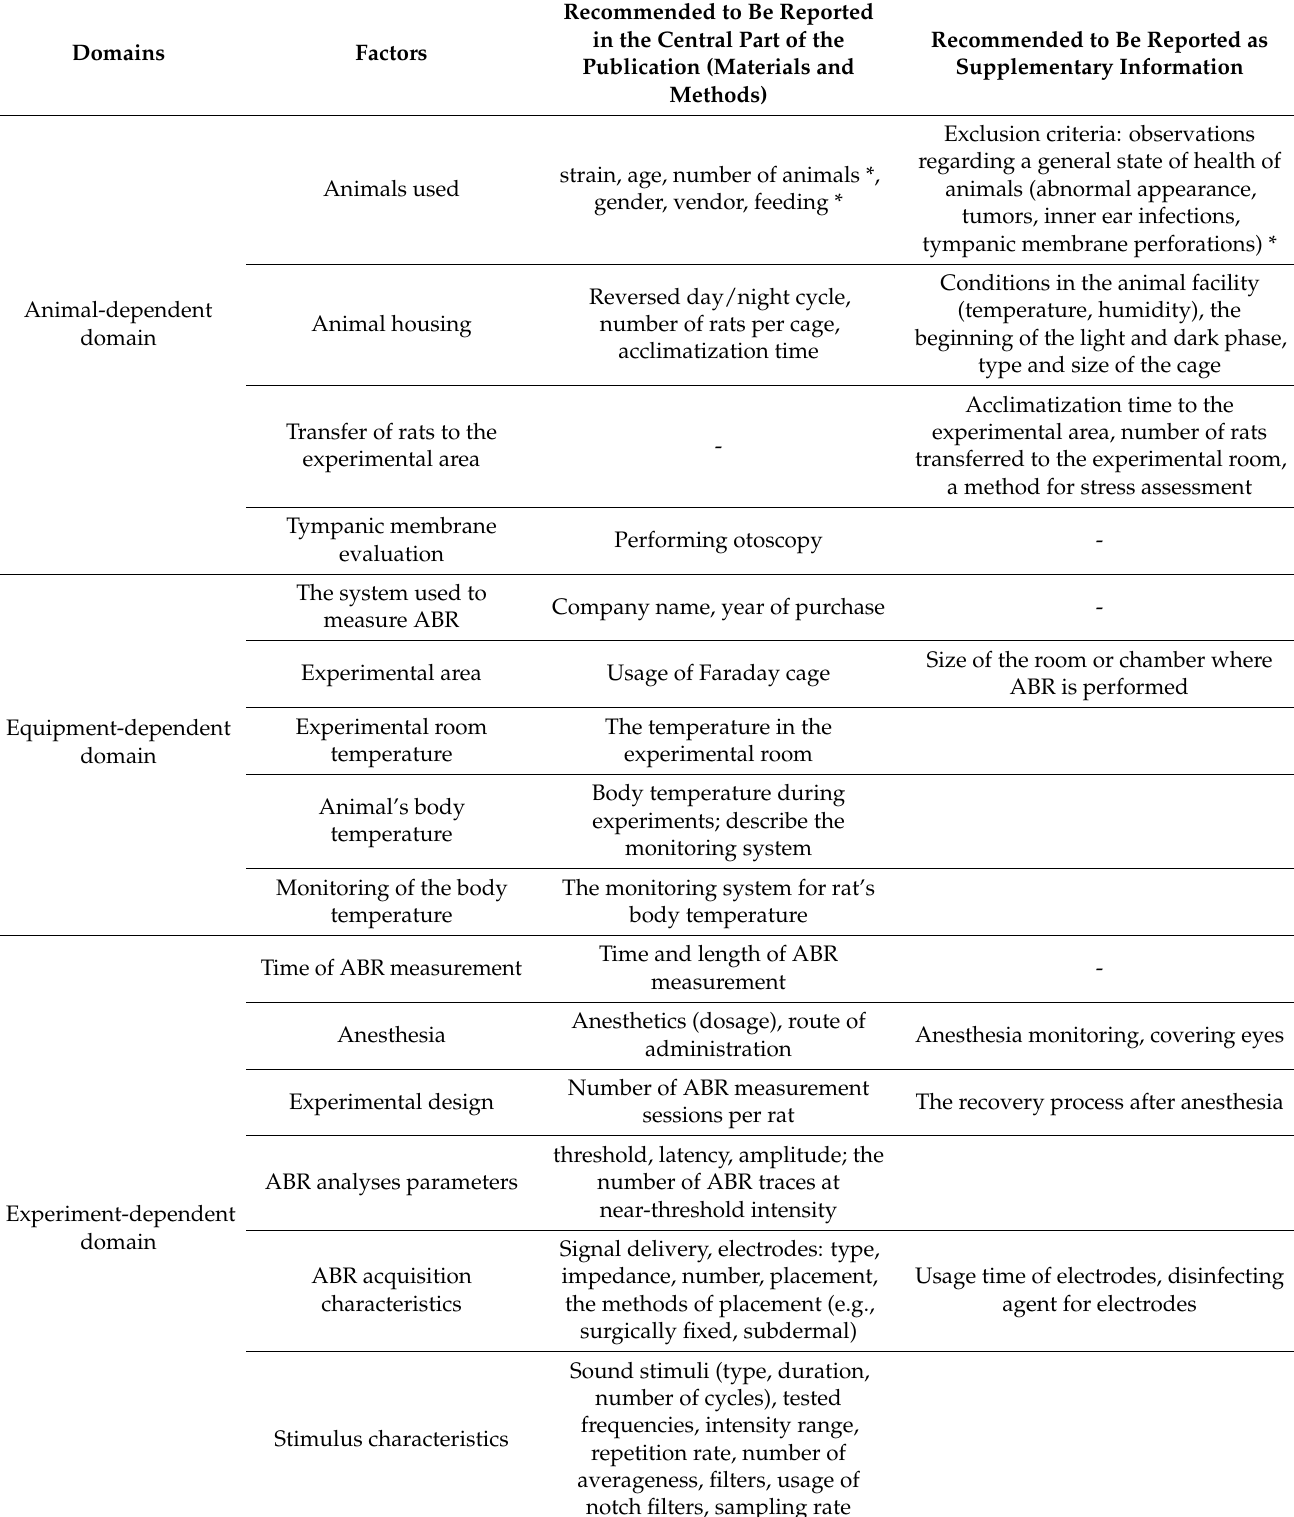
Table 4. Recommendation on reporting specific domains for the manuscripts concerning ABR in